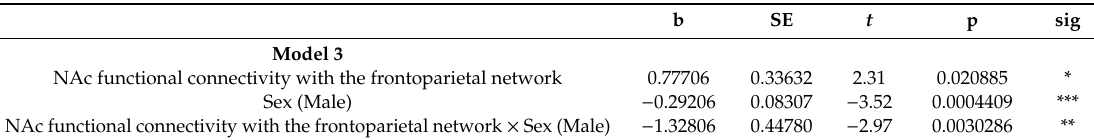
Table A3. Additive and multiplicative e ff ects of NAc functional connectivity with the frontoparietal network on BMI at baseline based on